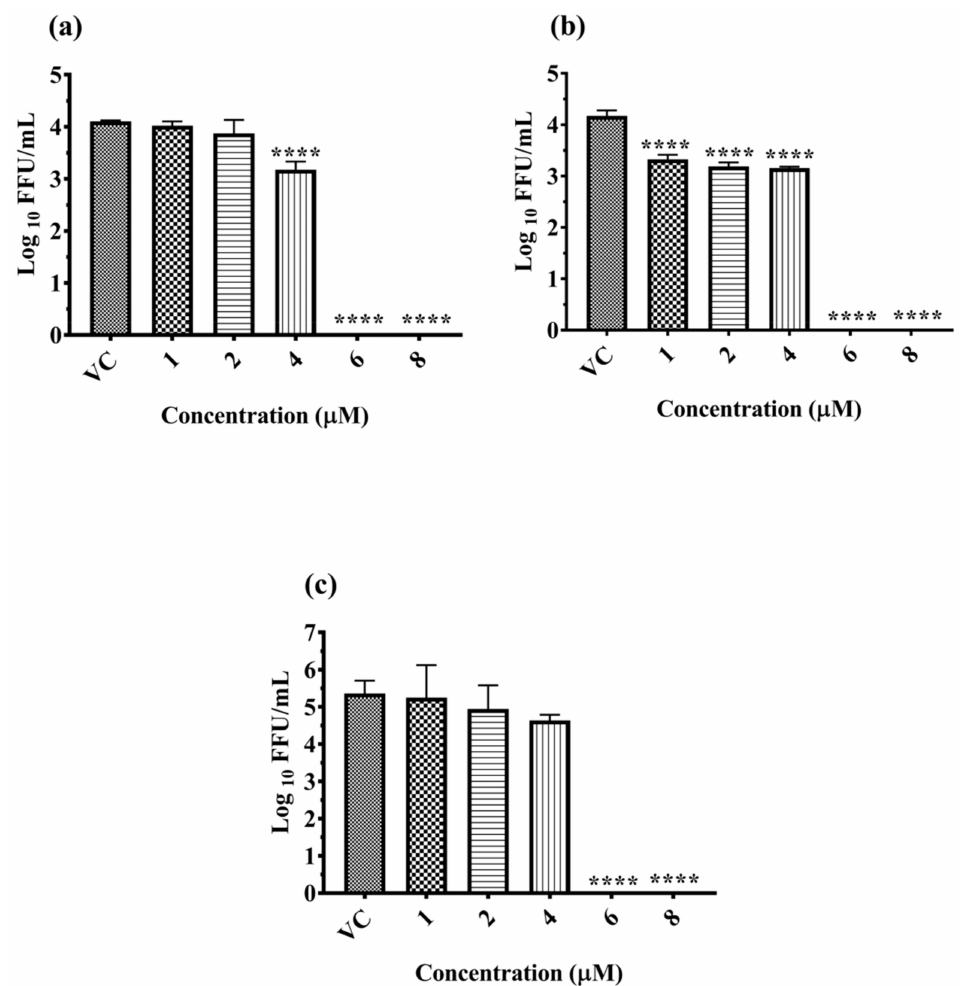
Figure 1. Effect of α -Mangostin on DENV-2 by focus forming unit assay under pre-treatment ( a ) co- treatment ( b ) and post-treatment ( c ) conditions. All the values are expressed as mean ± SD of three experiments. **** p < 0.0001, vs.